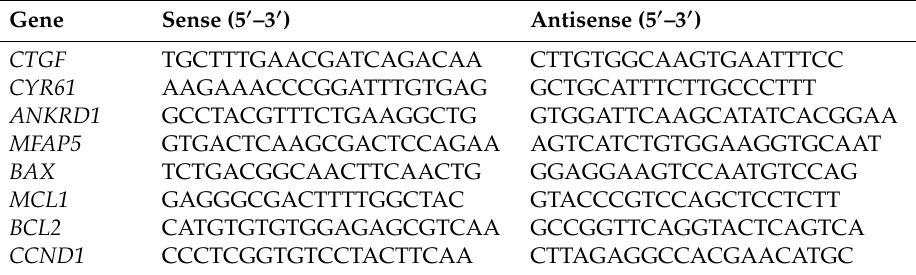
Table 1. List of primers for quantitative real-time